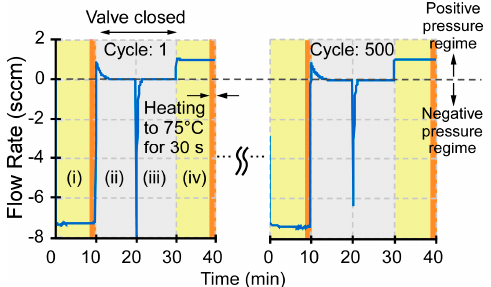
Figure 11. Cycling lifetime test of the microvalve. The sudden change of flow rate at t = 20 min. resulted from an imposed reversal of flow